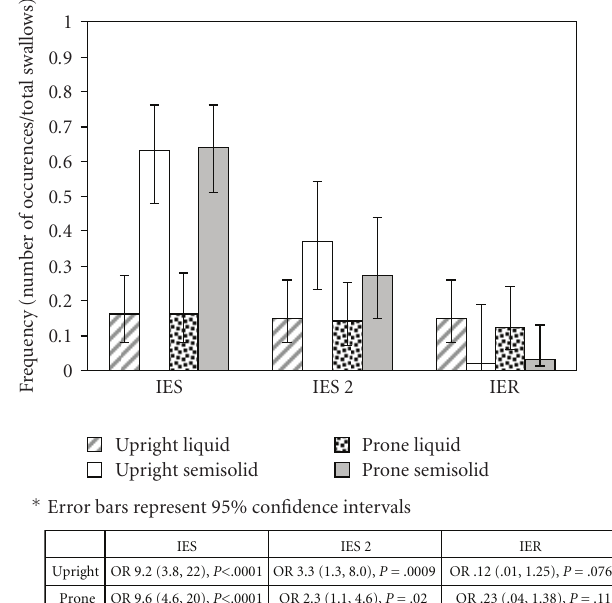
Figure 3: Frequency of IES, IES Grade 2 (IES 2) and IER in swallows of liquid and semisolid barium in the prone and upright positions.